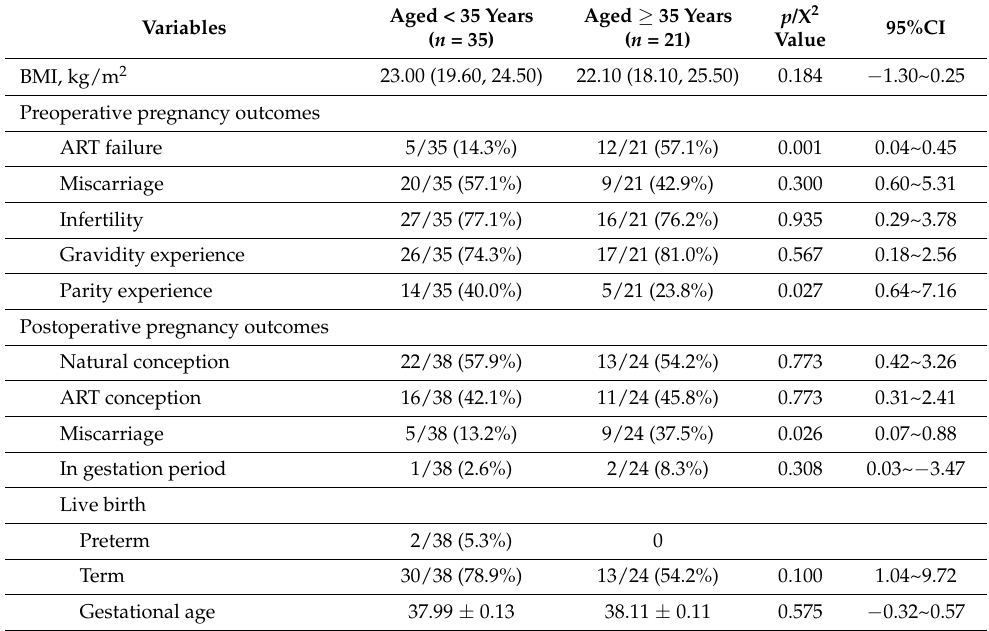
Table 2. Comparison of pregnancy outcomes between women aged <35 and aged ≥ 35 years ( n = 56).